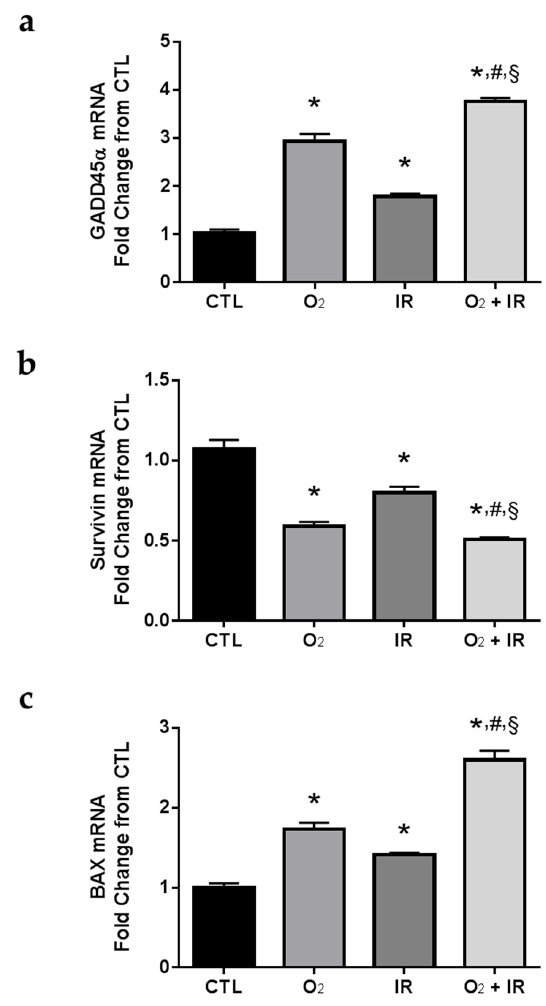
Figure 10. Evaluation of the effect of hyperoxia, radiation, or double-hit combination on apoptotic-relevant gene expression in murine lung tissue following 3 cycles of challenge exposure. Murine lung tissues ( n = 3/group) were evaluated after 3 cycles of hyperoxia and radiation exposure and evaluated by quantitative real-time PCR analysis for ( a ) GADD45 α ; ( b ) Survivin ; and ( c ) BAX gene expression. Levels of target gene mRNA were normalized to 18S ribosomal RNA and values are expressed as the mean fold change from CTL. Data are presented as mean ± SEM. * p < 0.05 for each exposure condition as it compares with the unexposed control (CTL) in the same respective time-group; # p < 0.05 for significant differences between O 2 -alone compared to O 2 + IR; § p < 0.05 for significant differences between IR-alone compared to O 2 + IR.